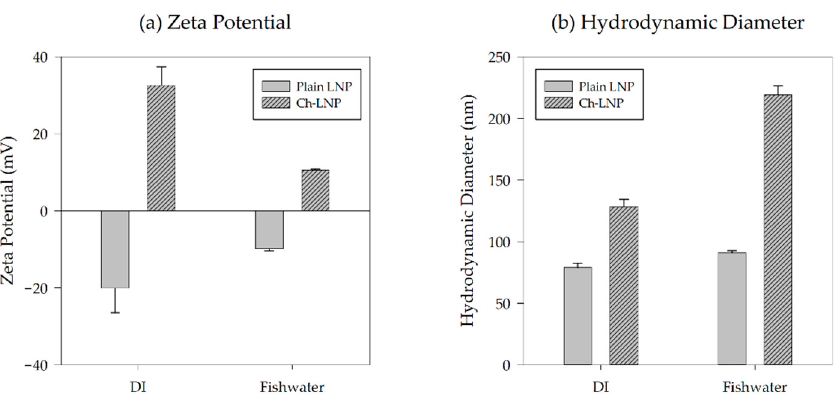
Figure 1. Analytical results showing ( a ) zeta potential and ( b ) HDD for the different particle formulations immediately after synthesis and after dispersal into fishwater prior to exposures.